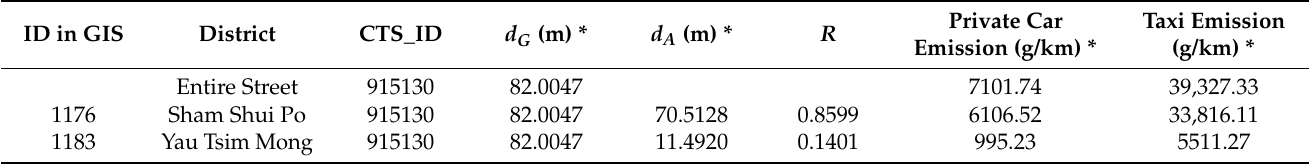
Table 2. Distribution of NO x emissions among Sham Shui Po and Yau Tsim Mong. (Yen Chow Street West, CTS_ID: 915130). ID in GIS